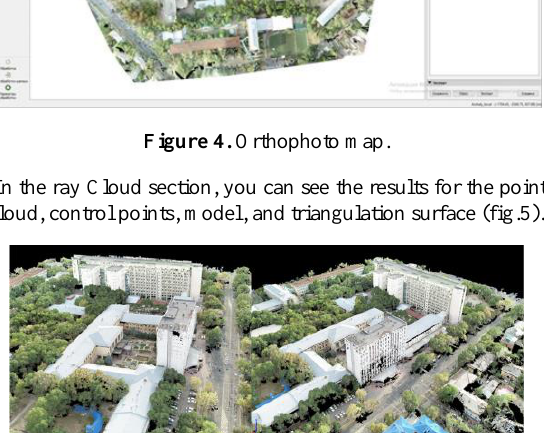
Figure 5. University model according to UAV